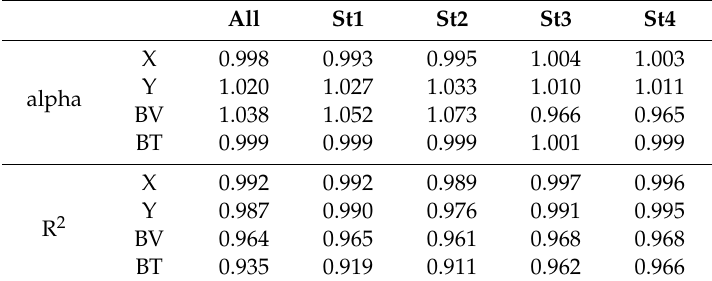
Table 2. Slope (alpha) and correlation coe ffi cients (R 2 ) from the regression of values extracted by the image-processing method and manual analysis without intercept. (manual data) = alpha x (automatic